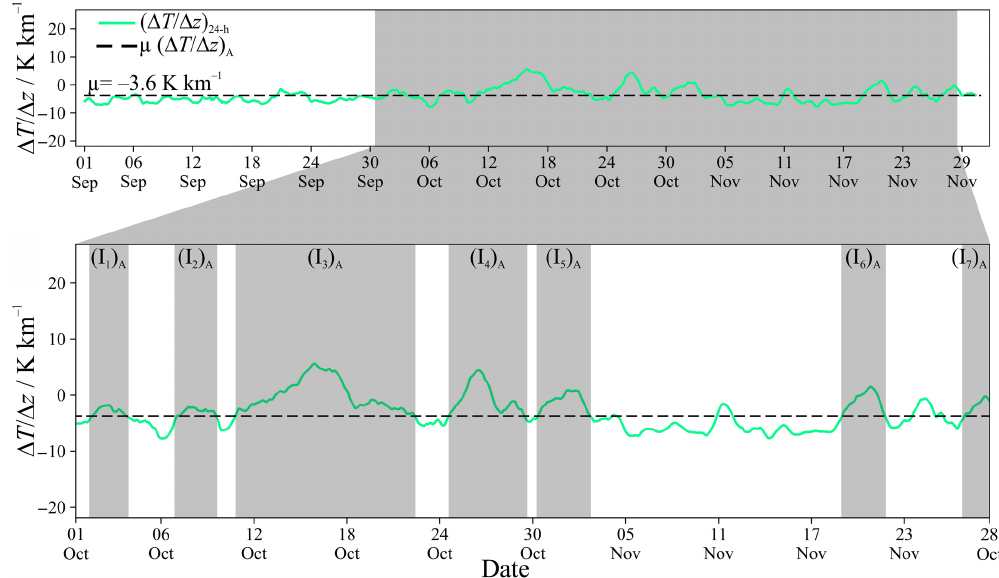
Figure 9. The 24h running mean of the pseudo-vertical temperature gradient in autumn; seven persistent temperature inversion events (I i ) A detected by the TGM are shown in the shaded section and enlarged in the breakout panel beneath; see text in Sect. 2.3.2 for details.